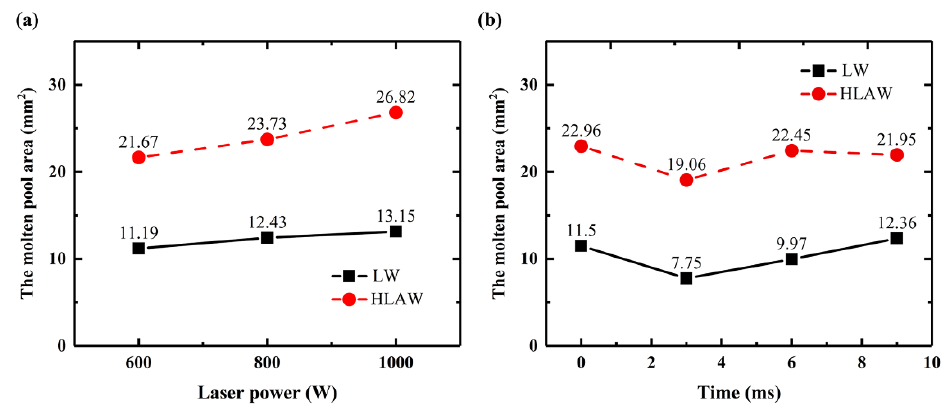
Figure 5. The molten pool area as functions of welding parameters: ( a ) laser power; ( b ) time in LW 600 and HLAW 600-20.